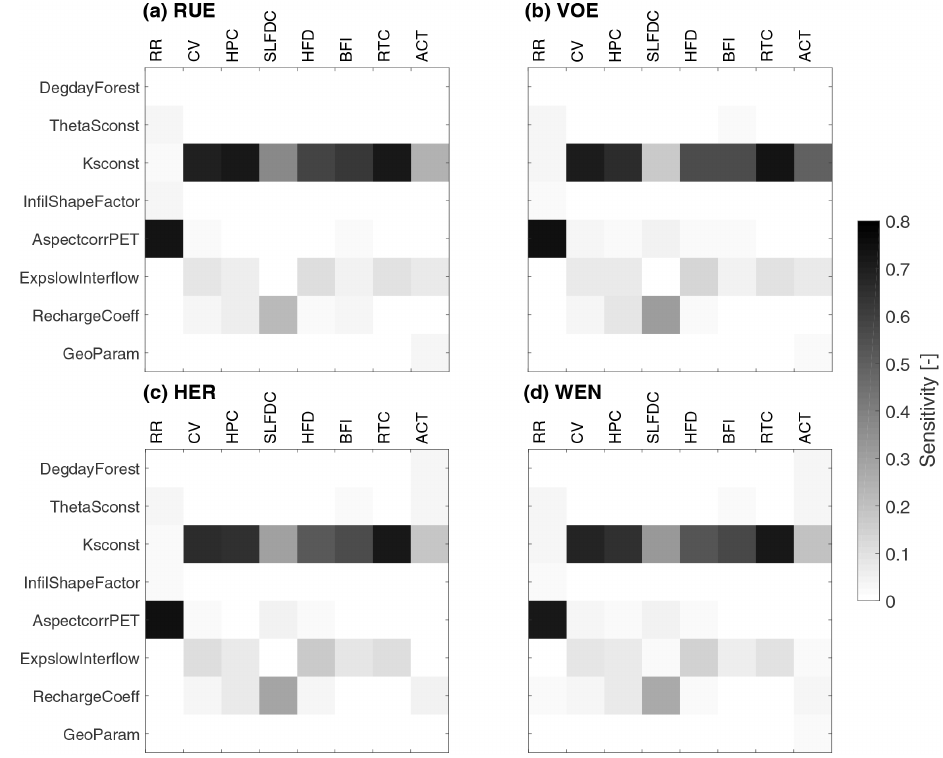
Figure 5. Sensitivity of eight global mHM parameters to eight single-value fingerprint metrics (RR, CV, HPC, SLFDC, HFD, BFI, RTC, ACT) in four Ruhr headwater catchments: RUE (a) , VOE (b) , HER (c) , WEN (d) . The simulation period was 1997 to 2006.